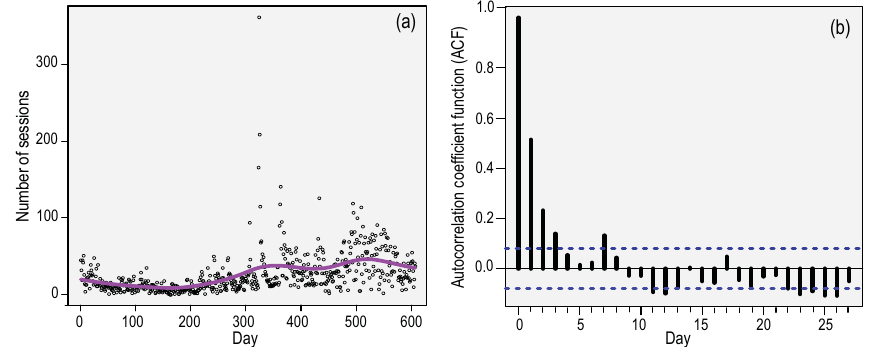
Figure 5. (a) Plot shows the original data (points) and the line (violet line) describing its trend. (b) Chart shows autocorrelation coefficient function (ACF) calculated using the time series of the number of sessions of the POLARIS